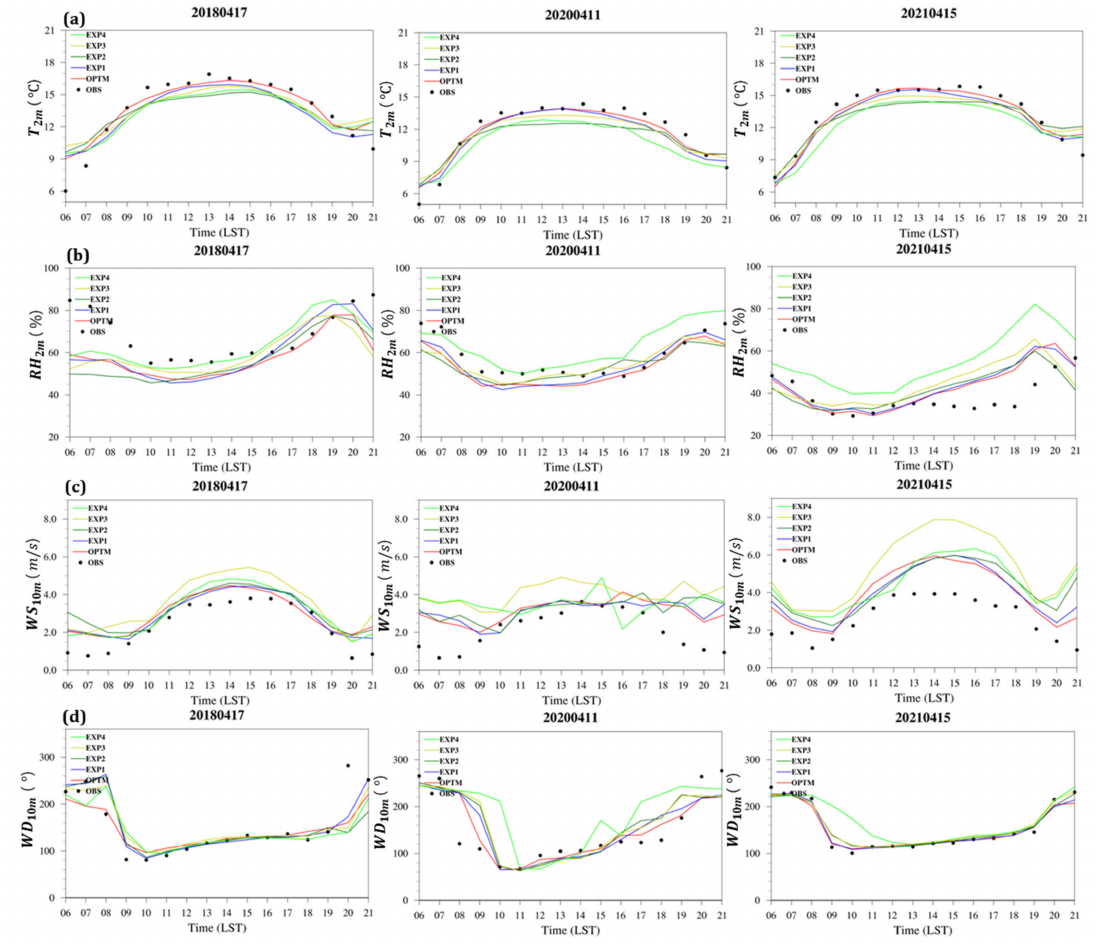
Figure 6. Time series of the surface variables averaged at the eight meteorological stations for different validation dates: ( a ) 2 m temperature, ( b ) 2 m relative humidity, ( c ) 10 m wind speed, and ( d ) 10 m wind direction, on 17 April 2018, 11 April 2020, and 15 April 2021,